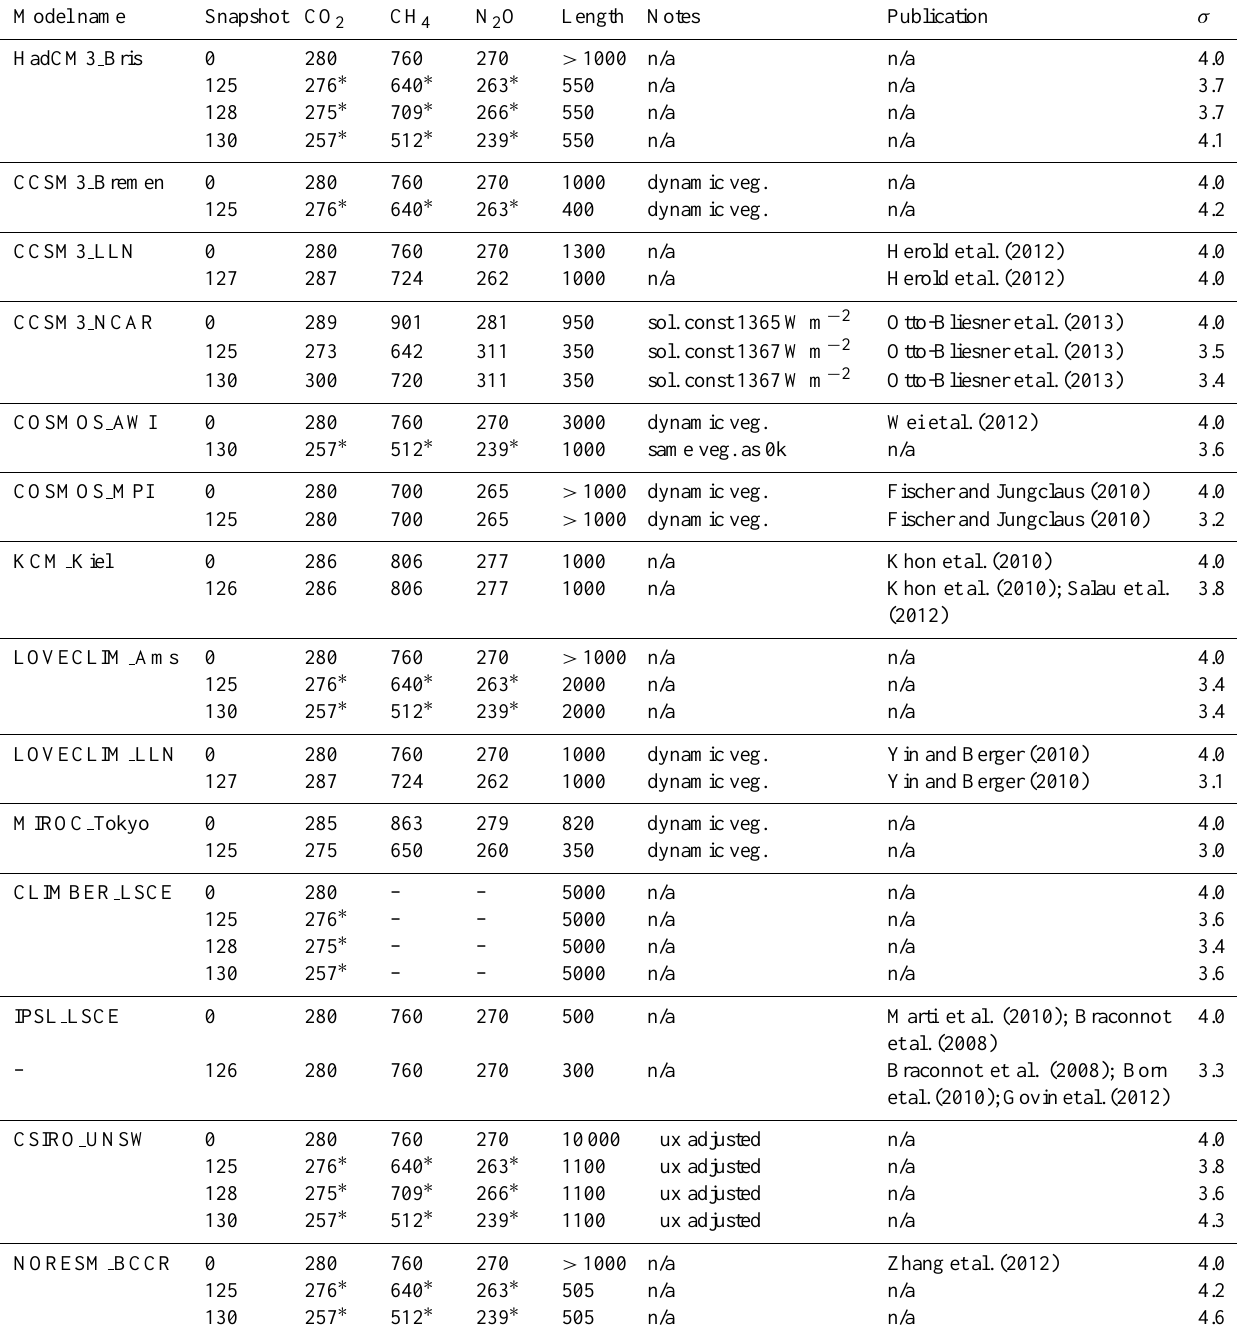
Table 2. Summary of simulations in this intercomparison. For the greenhouse gas concentrations, a “ ∗ ” indicates that the value is that specified by PMIP3. CO 2 is in units of ppmv, CH 4 and N 2 O are in units of ppbv. The LIG skill score, σ , is relative to the terrestrial data of Turney and Jones (2010), and is defined in Eq. (1). Note that CO 2 is the only greenhouse gas considered by